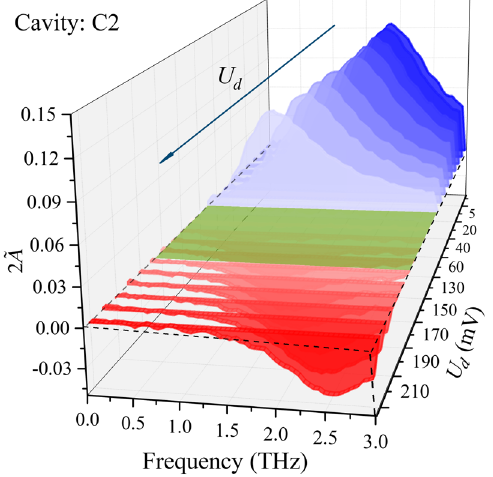
FIG. 8. Drain-bias-dependent spectra for the C 2 plasma cavity. Blue marks absorption, the green zone is the gap between absorption and emission, and red corresponds to amplification. The arrow indicates raising drain